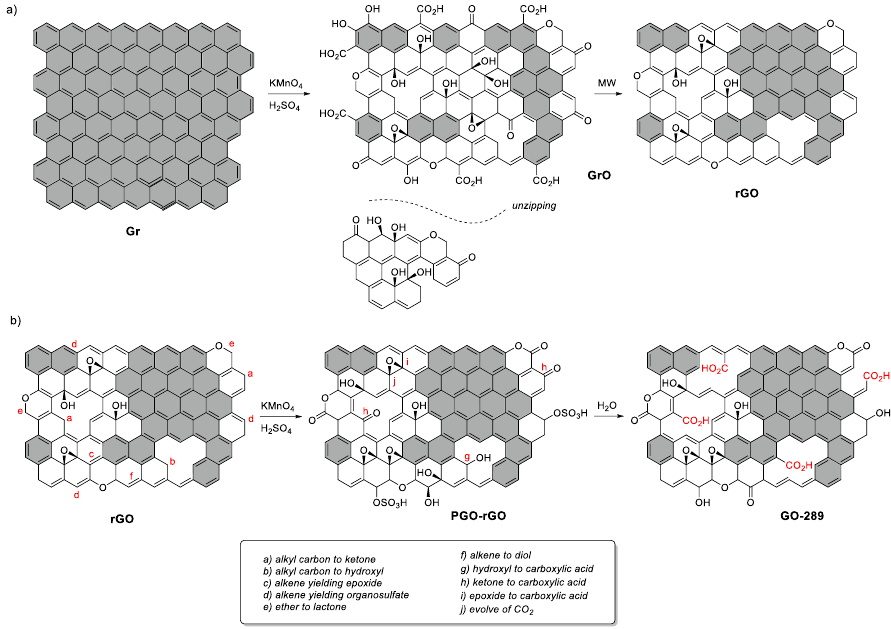
Figure 6. ( a ) Evolution of the graphene layer structure from stacked graphite to graphite oxide (GrO) after the Hummers – Offemann reaction (deep disruption of the delocalized py bonds with the formation of multiple oxygen functionalities, including sheet unzipping) and final graphene oxide (rGO) reduced by thermal treatment (which partially restores some of the py-delocalized cloud and resulting in the appearance of many new defects). ( b ) Evolution of the structure of rGO during the stages of the Hummers – Offemann method. The pristine graphene oxide (PGO) forms new hydroxyls and organosulfates on defects. Water solvation converts these hydroxyls and localized double bonds to carboxyls and anhydrides, respectively, leaving the aromatic domains nearly intact. Letters a to j illustrate the processes taking place during the oxidation and water